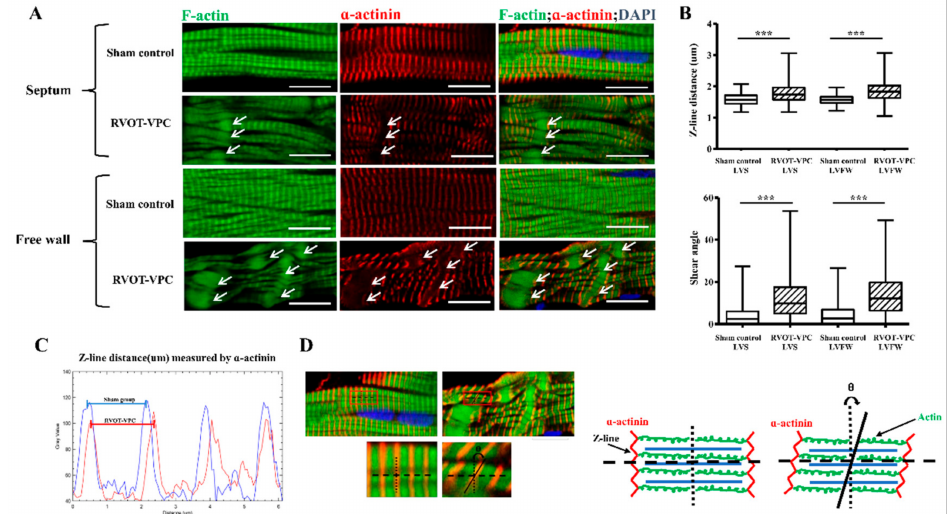
Figure 3. Sarcomere morphology, shear angle at the Z-line and the distance between two Z-lines following 6-month RVOT bigeminy VPCs. ( A ) Immunohistological studies of left ventricular septal and free wall myocardial tissue showed organized sarcomeres (homogenous distribution of F-actin in the sarcomeres, Z-lines in parallel, and equal distance between Z-lines (stained with α -actinin)) in the sham control group but showed that the sarcomere morphology and Z-line arrangement became disarrayed (non-homogenous distribution of F-actin in the sarcomeres and Z-lines not in parallel and different distances between two Z-lines) and spindle-shaped actin accumulations (white arrow) in the RVOT-VPC group. ( B – D ). The distance between two Z-lines (sarcomere length) and the shear angle at the Z-line (an indicator of reduced Z-direction contraction) were significantly increased in the cardiomyocytes of RVOT-VPC group compared to sham control group at both locations of left ventricle. The length of sarcomeres was measured as the distance between neighboring Z-lines, i.e., the distance between the neighboring peak immunofluorescent intensities of α -actinin ( C ). The shear angle at the Z-line was defined as the angle between Z-line and the line parallel to the actin in the same sarcomere, i.e., the angle between α -actinin and F-actin ( D ). DAPI staining for nuclei. Scale bar = 10 µ m. ***: p <